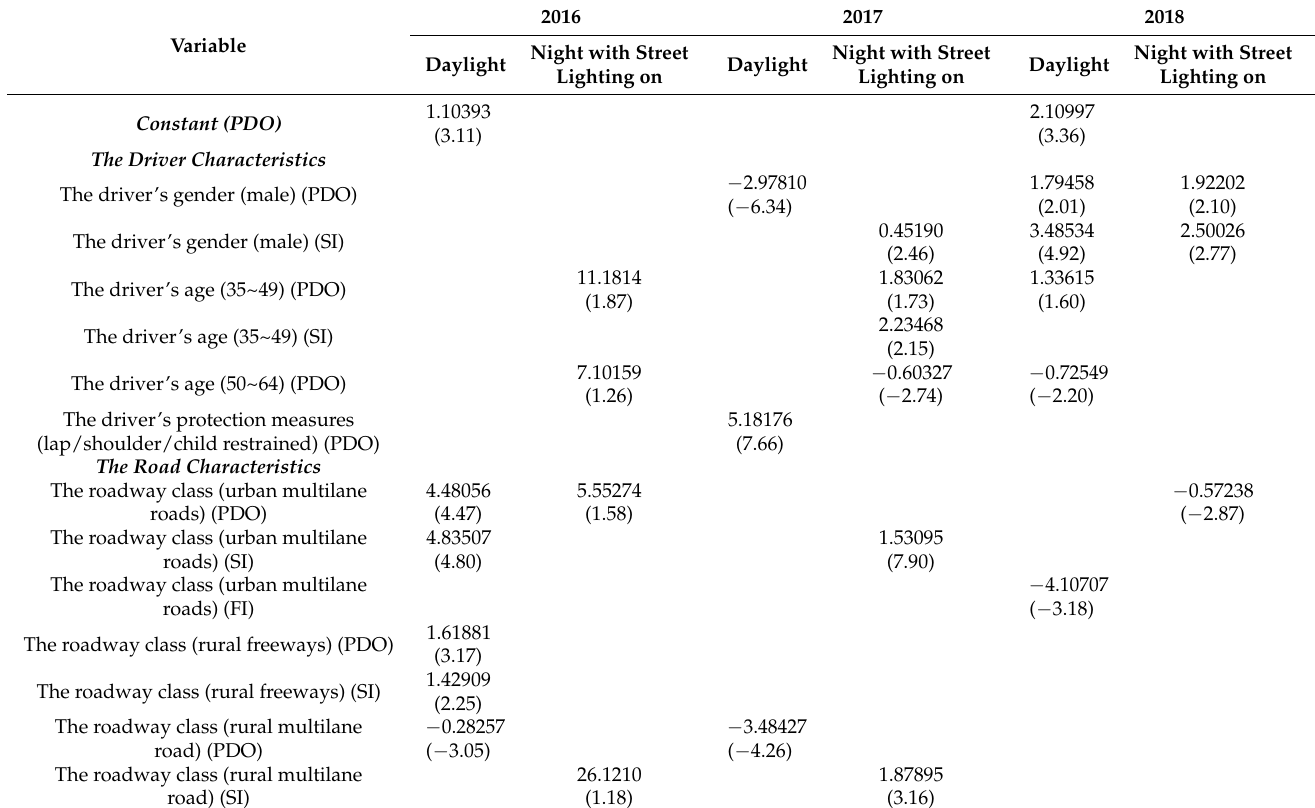
Table 3. The estimation results of the random parameters models in 2016, 2017, and